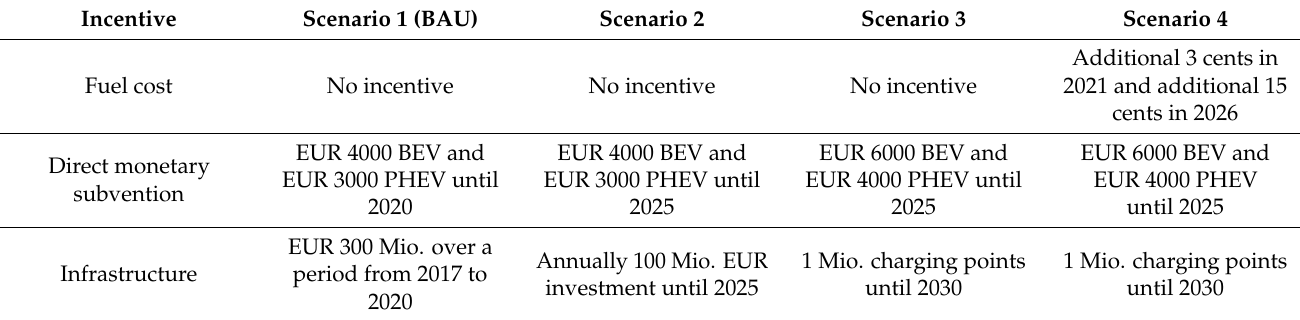
Table 3. Breakdown of the investigated